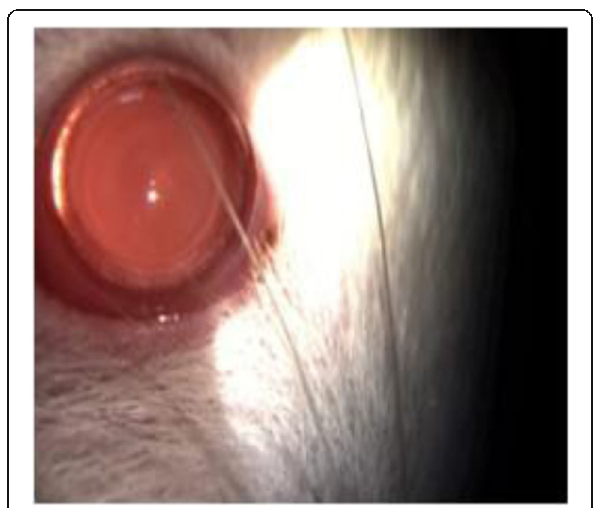
Fig. 1 Slit lamp photography of control group showing clear